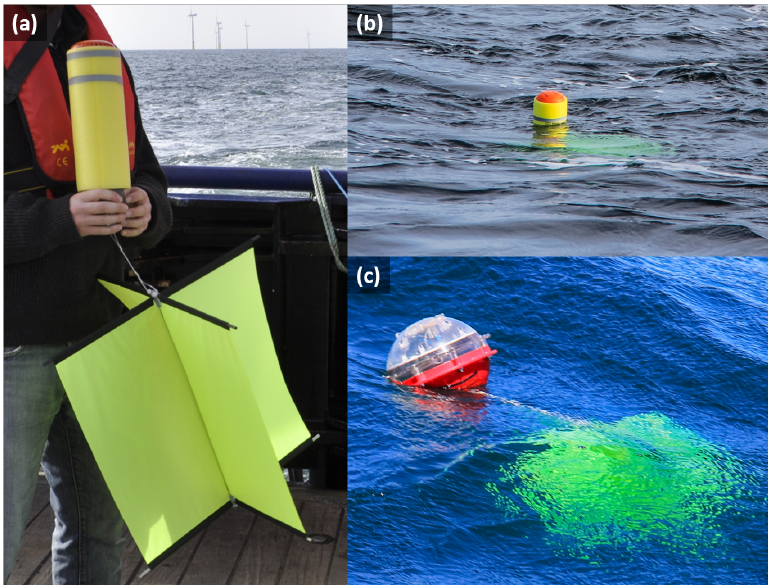
Figure 1. Drifter types MD03i (panels a and b ) and ODi (panel c ) used during the experiment. Both drifter types were photographed shortly after launch so that the drogues had not yet